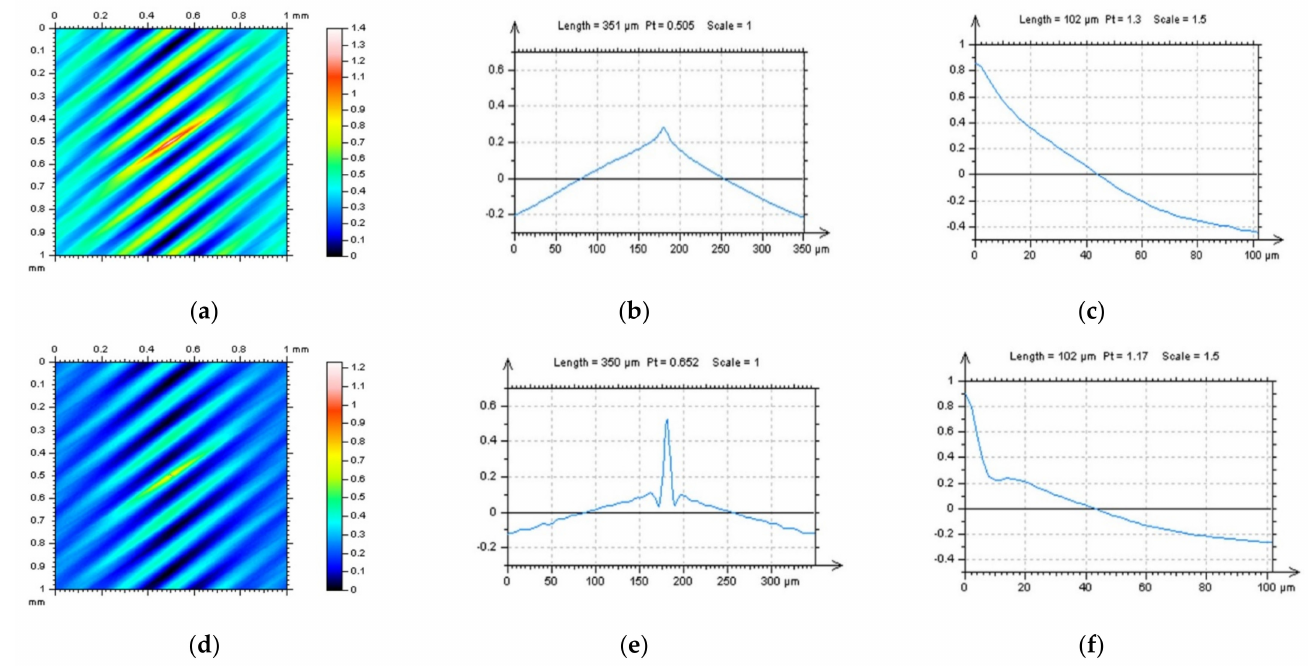
Figure 2. ACFs analysis received for surfaces M1(1) ( a – c ) and M1(2) ( d – f ), ACFs for surfaces ( a , d ), their extracted ( b , e ) and zoomed centre ( c , f ) profile parts with length equal to (approximately) 400 µ m (medium column) and 100 µ m (right column).